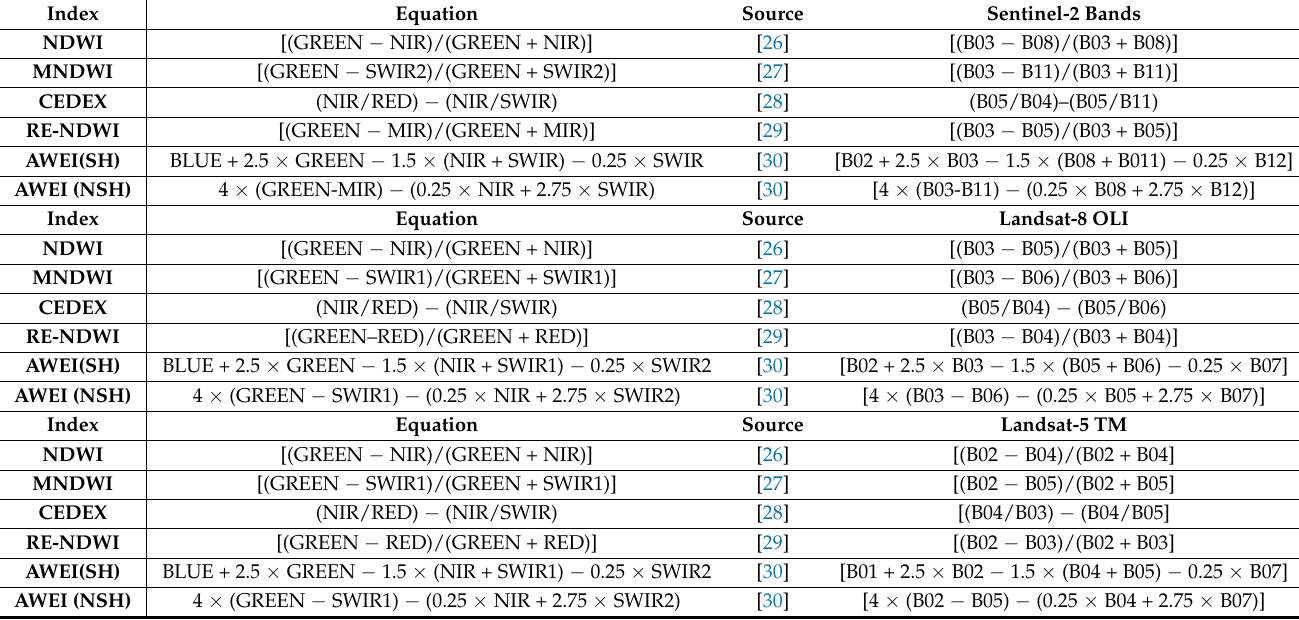
Table 1. Calculated spectral